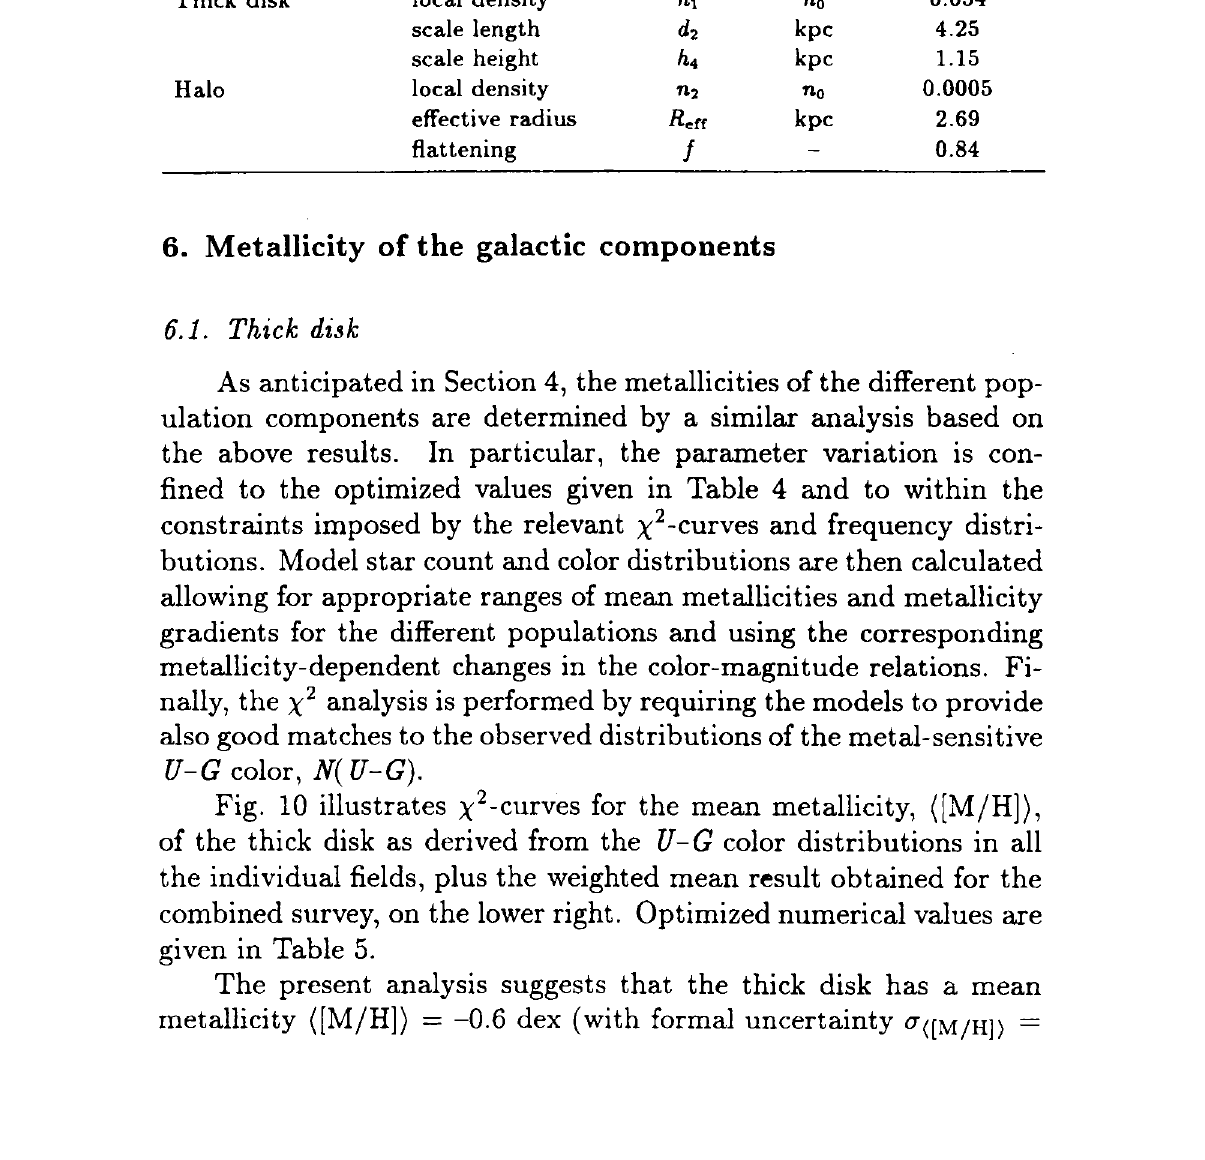
Table 4. Best-fitting parameter values for the combined survey of the seven fields Component